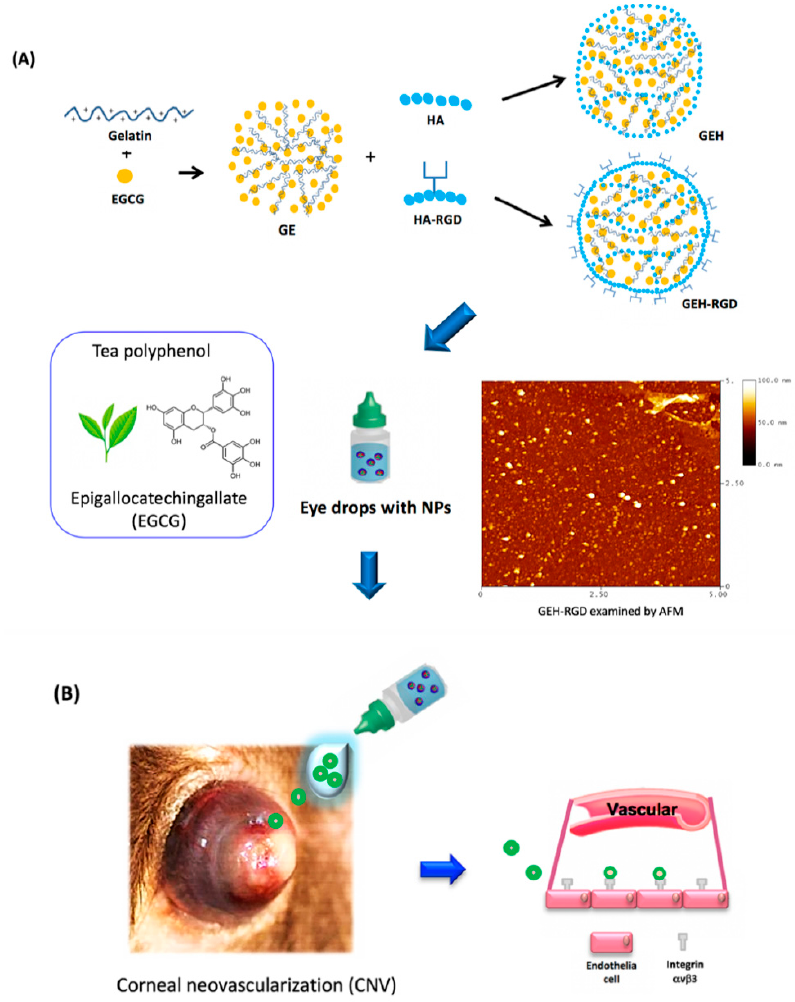
Figure 1. Schematic illustration of this study. ( A ) Synthesis of GEH-RGD NPs with EGCG loading and ( B ) application in corneal NV treatment as an eye drop formulation. Abbreviation: EGCG: epigallocatechin-3 gallate, HA: hyaluronic acid, NPs: nanoparticles, RGD: arginine-glycine-aspartic acid, GE: Gelatin / EGCG self-assembling NPs, GEH: GE NPs with HA surface coating, GEH-RGD: GE NPs with HA-RGD surface decoration, AFM: atomic force microscope.